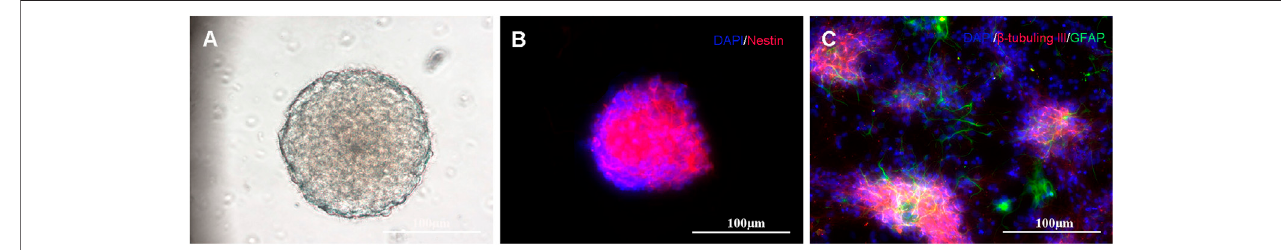
FIGURE 4 | Primary culture and characterization of NSCs: (A) NSCs cultured in serum-free medium for 7 days; (B) Immunostaining of NSCs with nestin antibody (shown in red) and DAPI (shown in blue); and (C) When transferred to the differentiating state, the neurospheres expressed neuronal ( β -tubulin III, shown in red) and astrocytic markers (GFAP, shown in green).